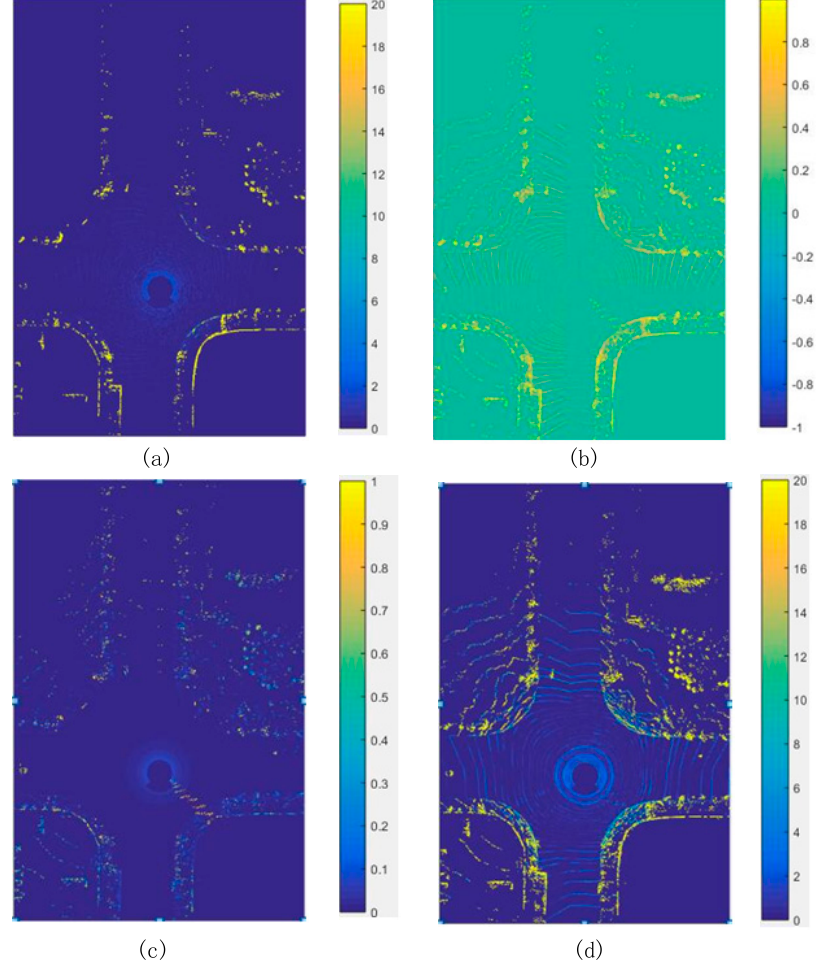
Figure 8. Value distribution of the four features in a crossroad. ( a ) Maximum height difference in one grid; ( b ) Tangential angle feature; ( c ) Distance change between neighboring points in one spin; ( d ) Height difference based on the prediction of the radial gradient.